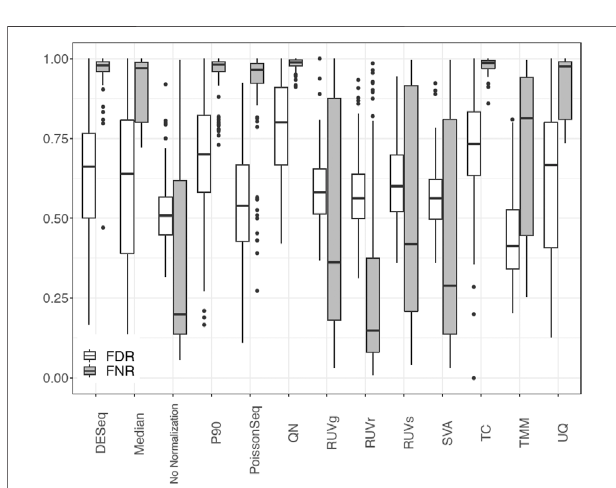
FIGURE 3 | Boxplot of FDR and FNR in 100 pairs of simulated data sets for P90 normalization in comparison with no normalization and nine normalization methods using PRECISION.